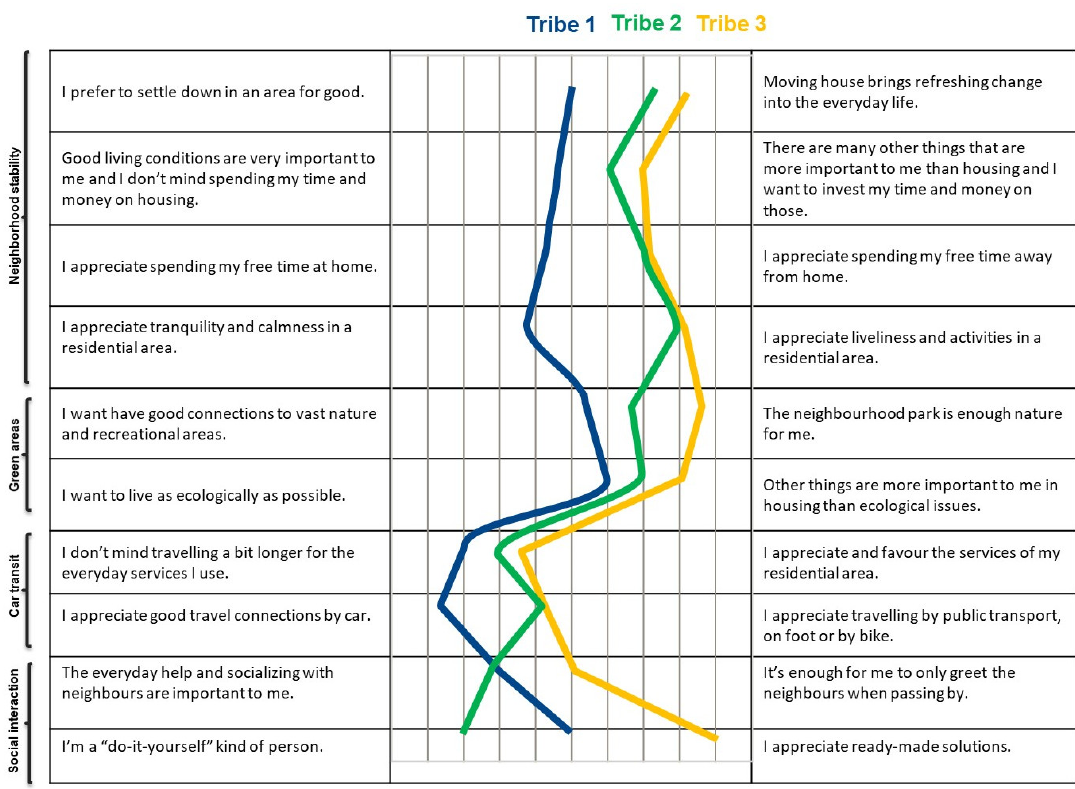
Figure 2. Profiles of three urban tribes based on the cluster centers [30]. Tribe 1: Urbanist (36%); Tribe 2: Semi-urbanist (29%); Tribe 3: Nature lover (35%).